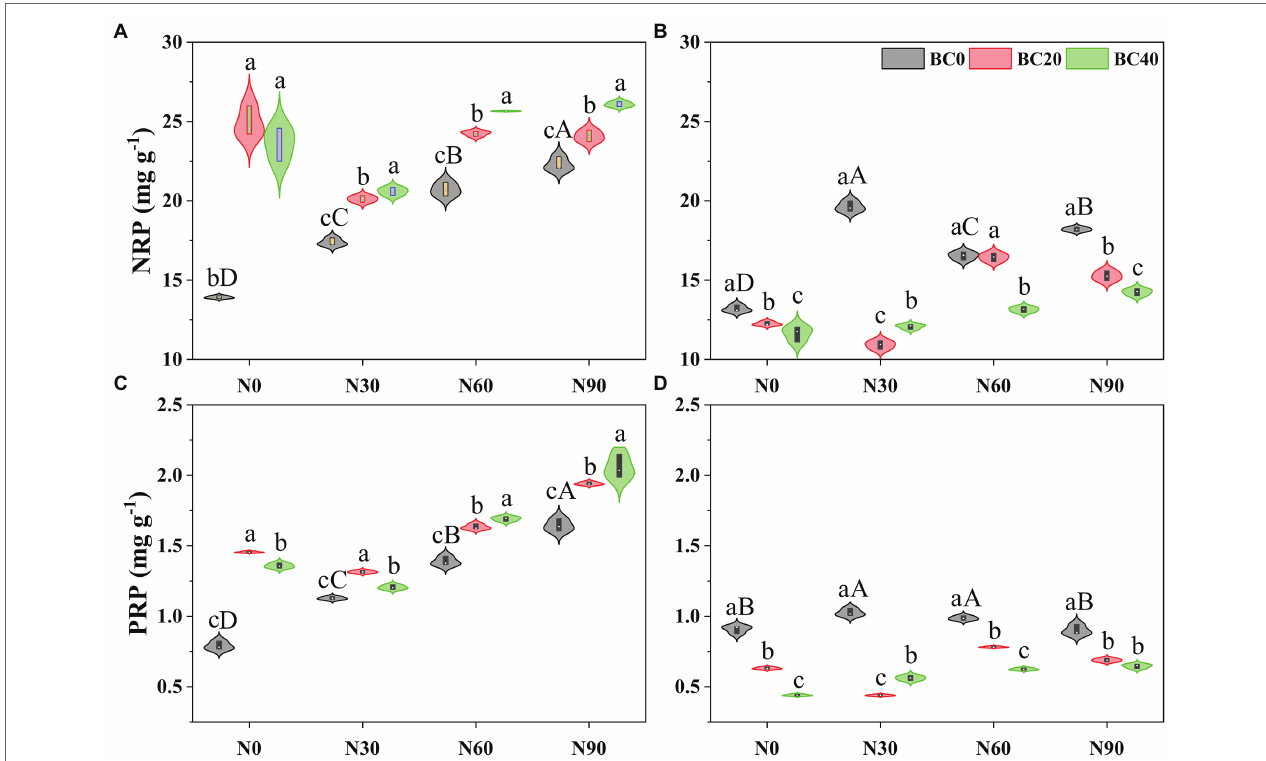
FIGURE 2 | Nitrogen resorption proficiency (NRP) and phosphorus resorption proficiency (PRP) of young (A,C) and mature (B,D) bamboo under different N addition and biochar amendment treatments. N0, N30, N60, and N90 refer to 0, 30, 60, and 90 kg N ha − 1 yr − 1 , respectively, and BC0, BC20, and BC40 refer to 0, 20, and 40 t biochar ha − 1 . Capital letters indicate a significant difference between different N addition treatments in the BC0 treatment at the 0.05 level. Lowercase letters indicate a significant difference between different biochar treatments in the same N addition treatment at the 0.05